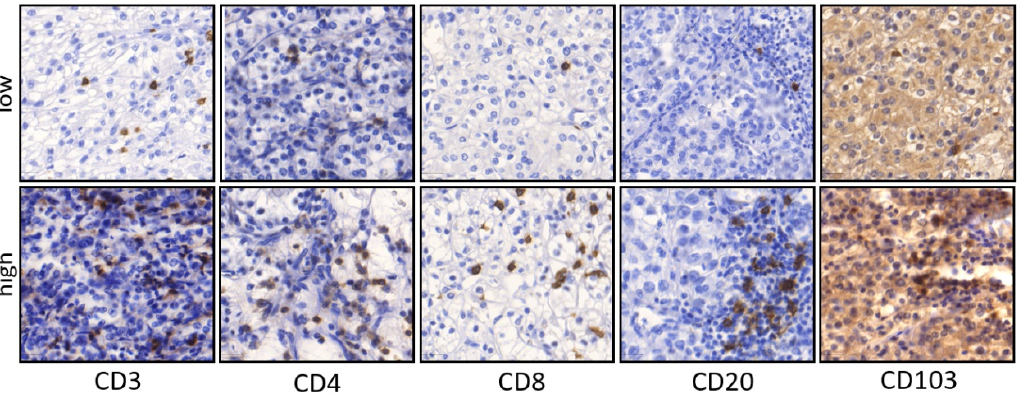
Figure 1. Representative pictures of IHC staining in primary ccRCC. Examples for low and high densities of CD3, CD4, CD8, CD20 and CD103 positive cells in primary ccRCC (×200 magnification). Table 2. Correlation of intratumoral immune cell infiltrate with clinico-pathological parameters (Mann–Whitney U test, Bonn cohort, 50 patients).